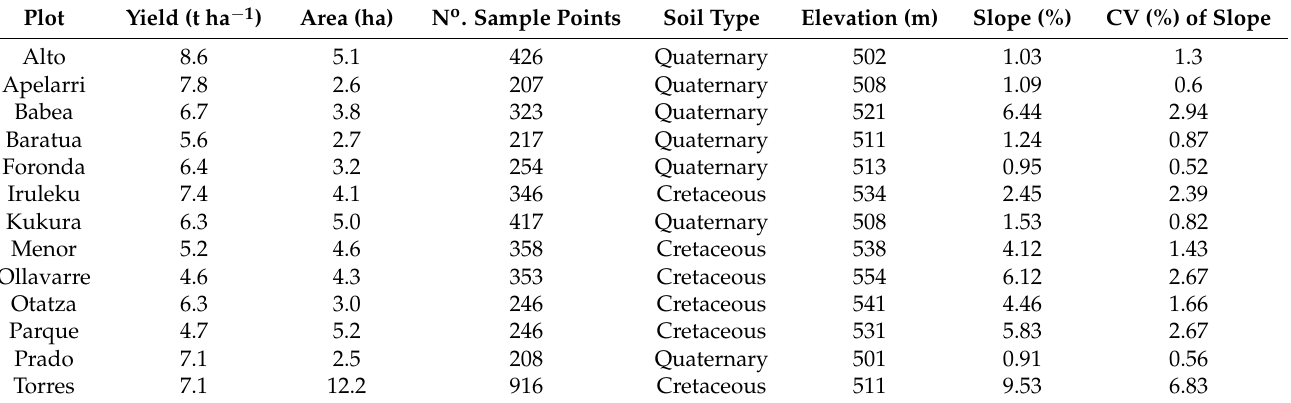
Table 2. Mean yield, area, number of yield sample points into each plot, and the corresponding soil type. Elevation, slope, and slope coefficient of variation have been obtained from